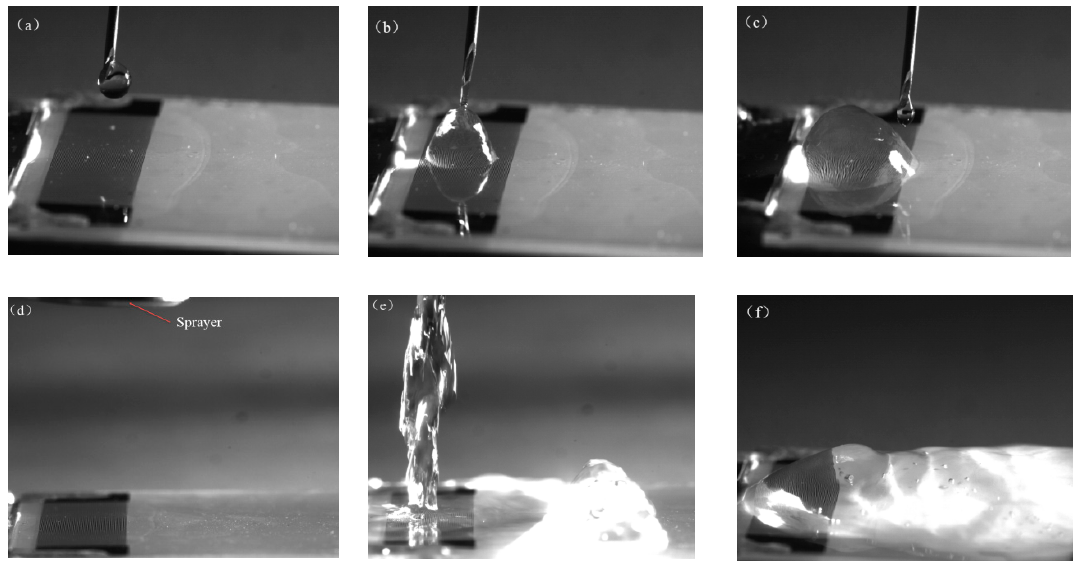
Figure 4. Waterproof performance tests of the surface acoustic wave (SAW) device with the film coating. ( a – c ) The electrode dripping test. ( d – f ) Corresponding images of the electrode water-